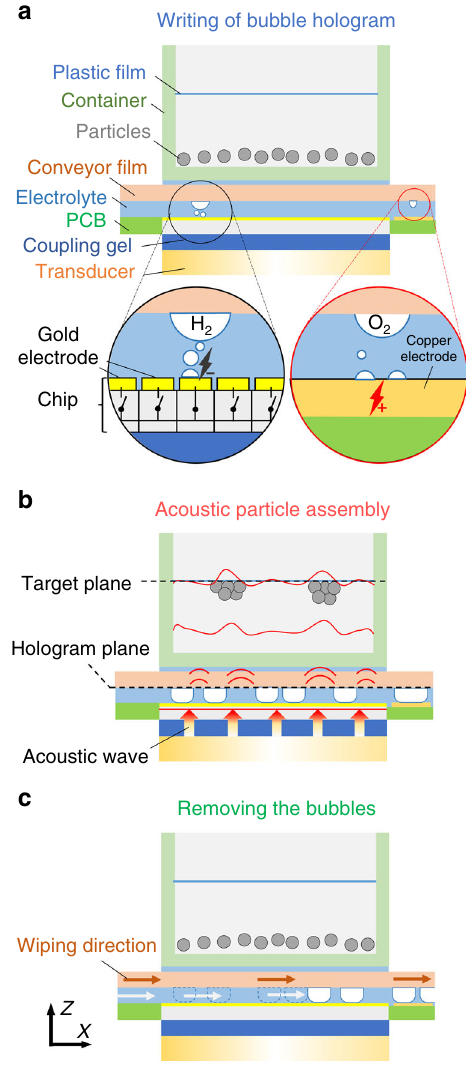
Fig. 2 Schematic of the stepwise actuation of the rewritable acoustic hologram. a A bubble pattern is generated on-demand by a complementary metal – oxide – semiconductor (CMOS) chip with 100 × 100 electronically addressable pixels. A controlled current at each pixel causes electrolysis. b An ultrasonic transducer generates a plane acoustic wave that transmits through the chip. The presence of a microbubble locally blocks the acoustic wave. Thus, a spatially modulated wavefront is generated that represents a binary amplitude hologram. The wave passes only through the bubble-free regions. The modulated acoustic wave propagates and diffracts to form an acoustic image at the target plane. Suspended particles are concentrated in areas of high acoustic amplitude by the acoustic radiation force. c A conveyor-driven polymer fi lm removes the bubble pattern, and the cycle